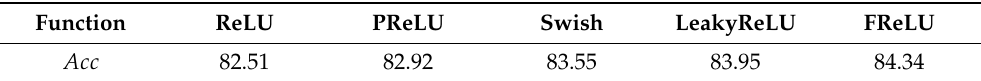
Table 2. Effectiveness of introducing FReLU into the WPGN. Function ReLU PReLU Swish LeakyReLU FReLU Acc 82.51 82.92 83.55 83.95